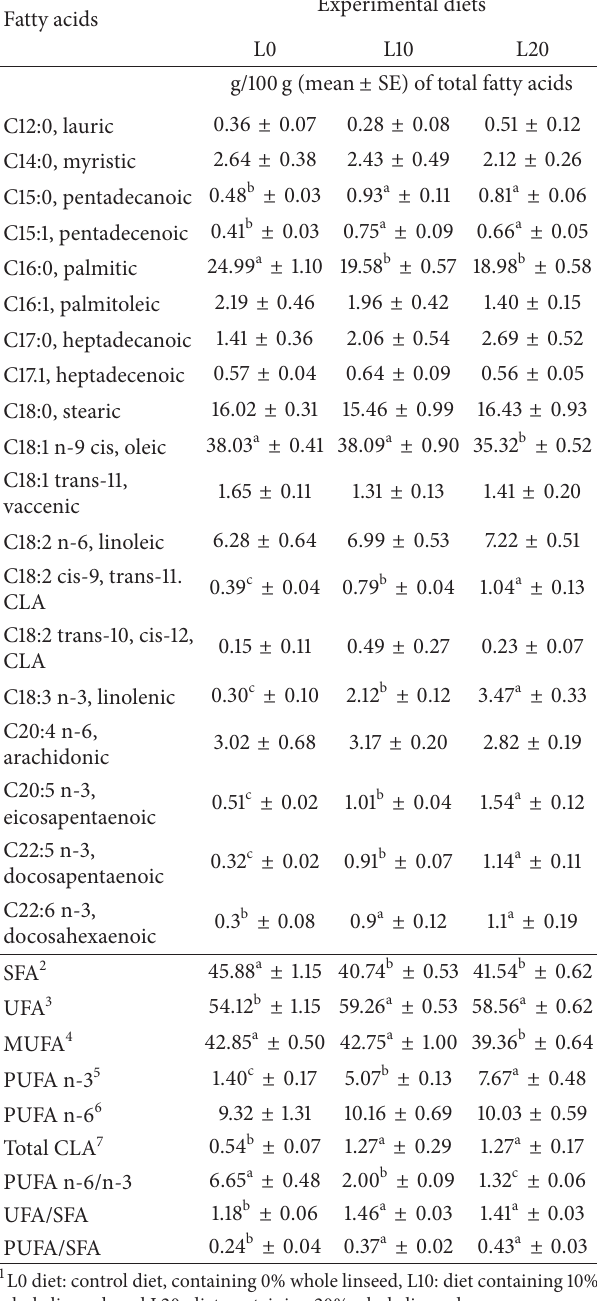
Both the SF and PF of the control group had higher